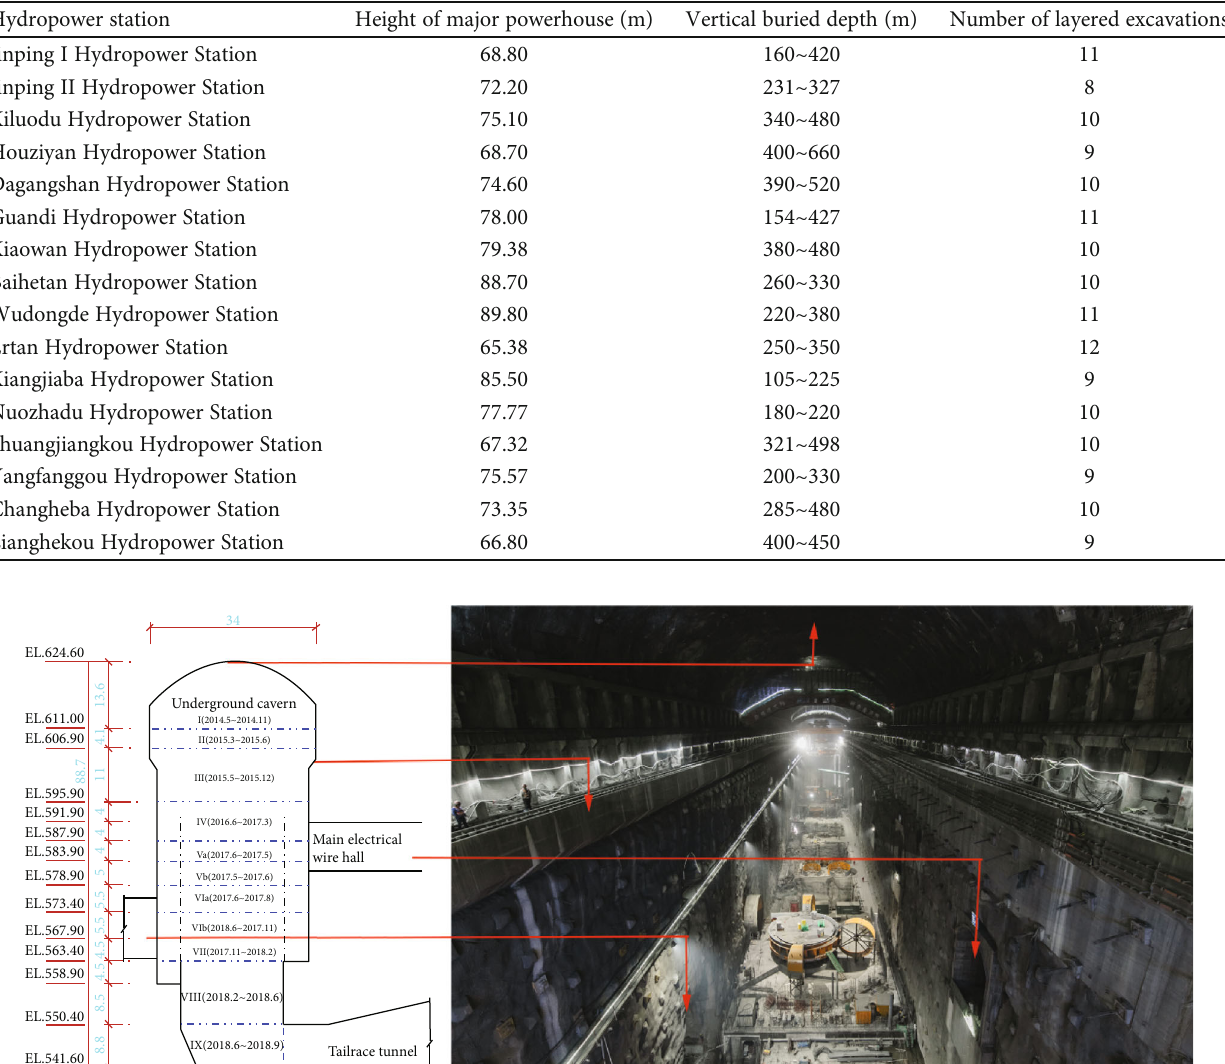
Table 1: Statistics of representative hydropower station underground powerhouses in Southwest China.